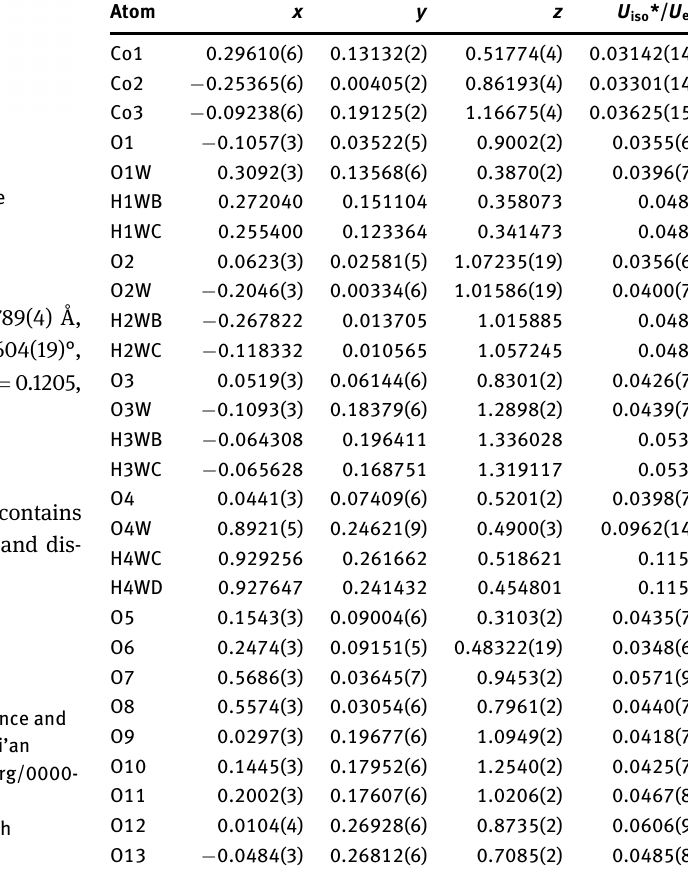
Table 2: Fractional atomic coordinates and isotropic or equivalent isotropic displacement parameters (Å 2